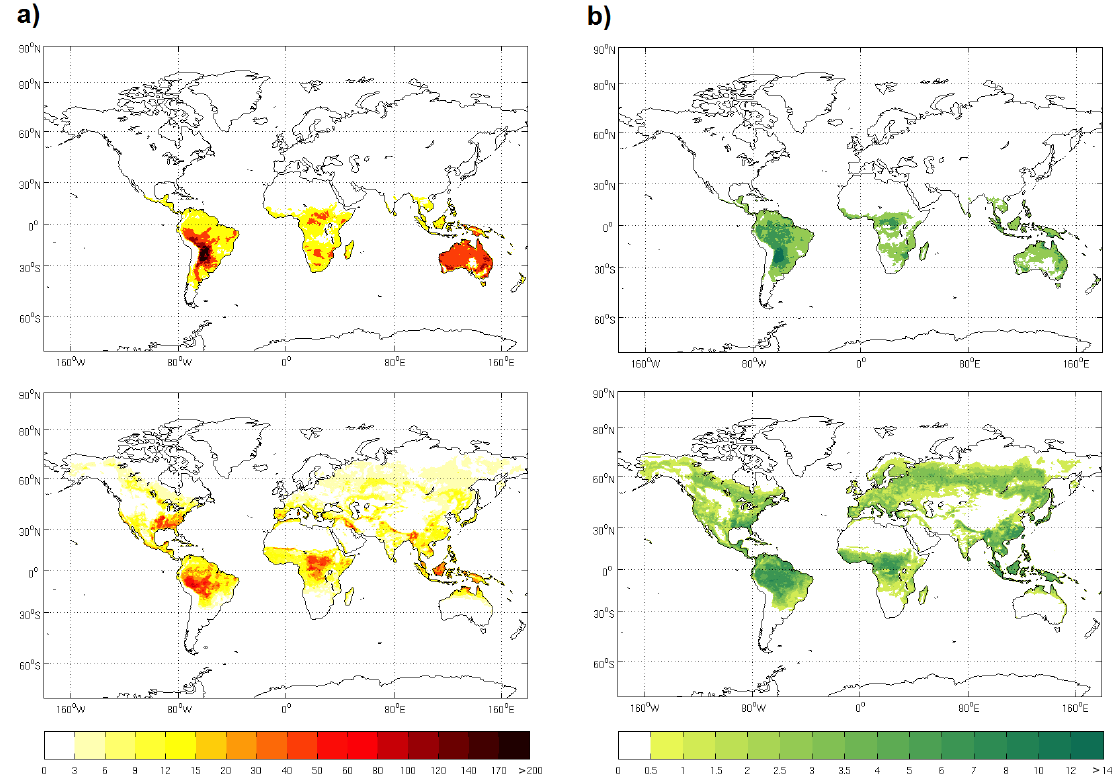
Figure 2. Spatial distribution of monthly mean emissions of (a) isoprene, (b) monoterpenes, (mgm − 2 day − 1 ) for January (top) and July (bottom) averaged over the modelled period 1980–2010 calculated by the MEGAN model.